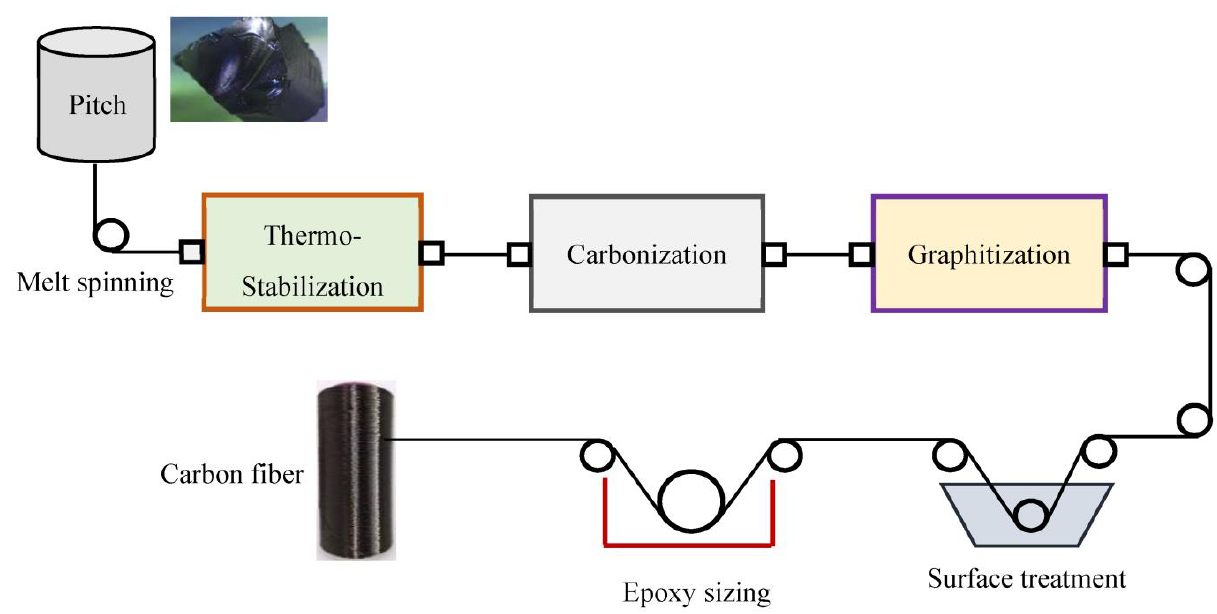
Figure 3. Carbon fiber production using petroleum pitch precursor.